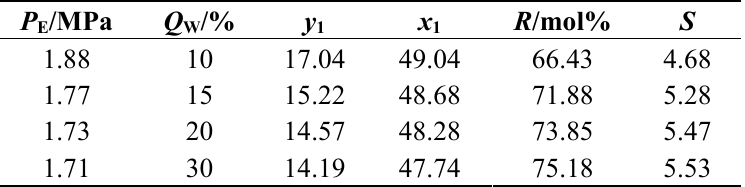
Table 4. Separation results for C 2 H 4 /CH 4 (30.08/69.92 mol%) in diesel-water emulsion with different water cuts. Temperature, initial pressure, and initial gas-liquid volume ratio were specified to 274.15 K, 3.4 MPa, and 80,